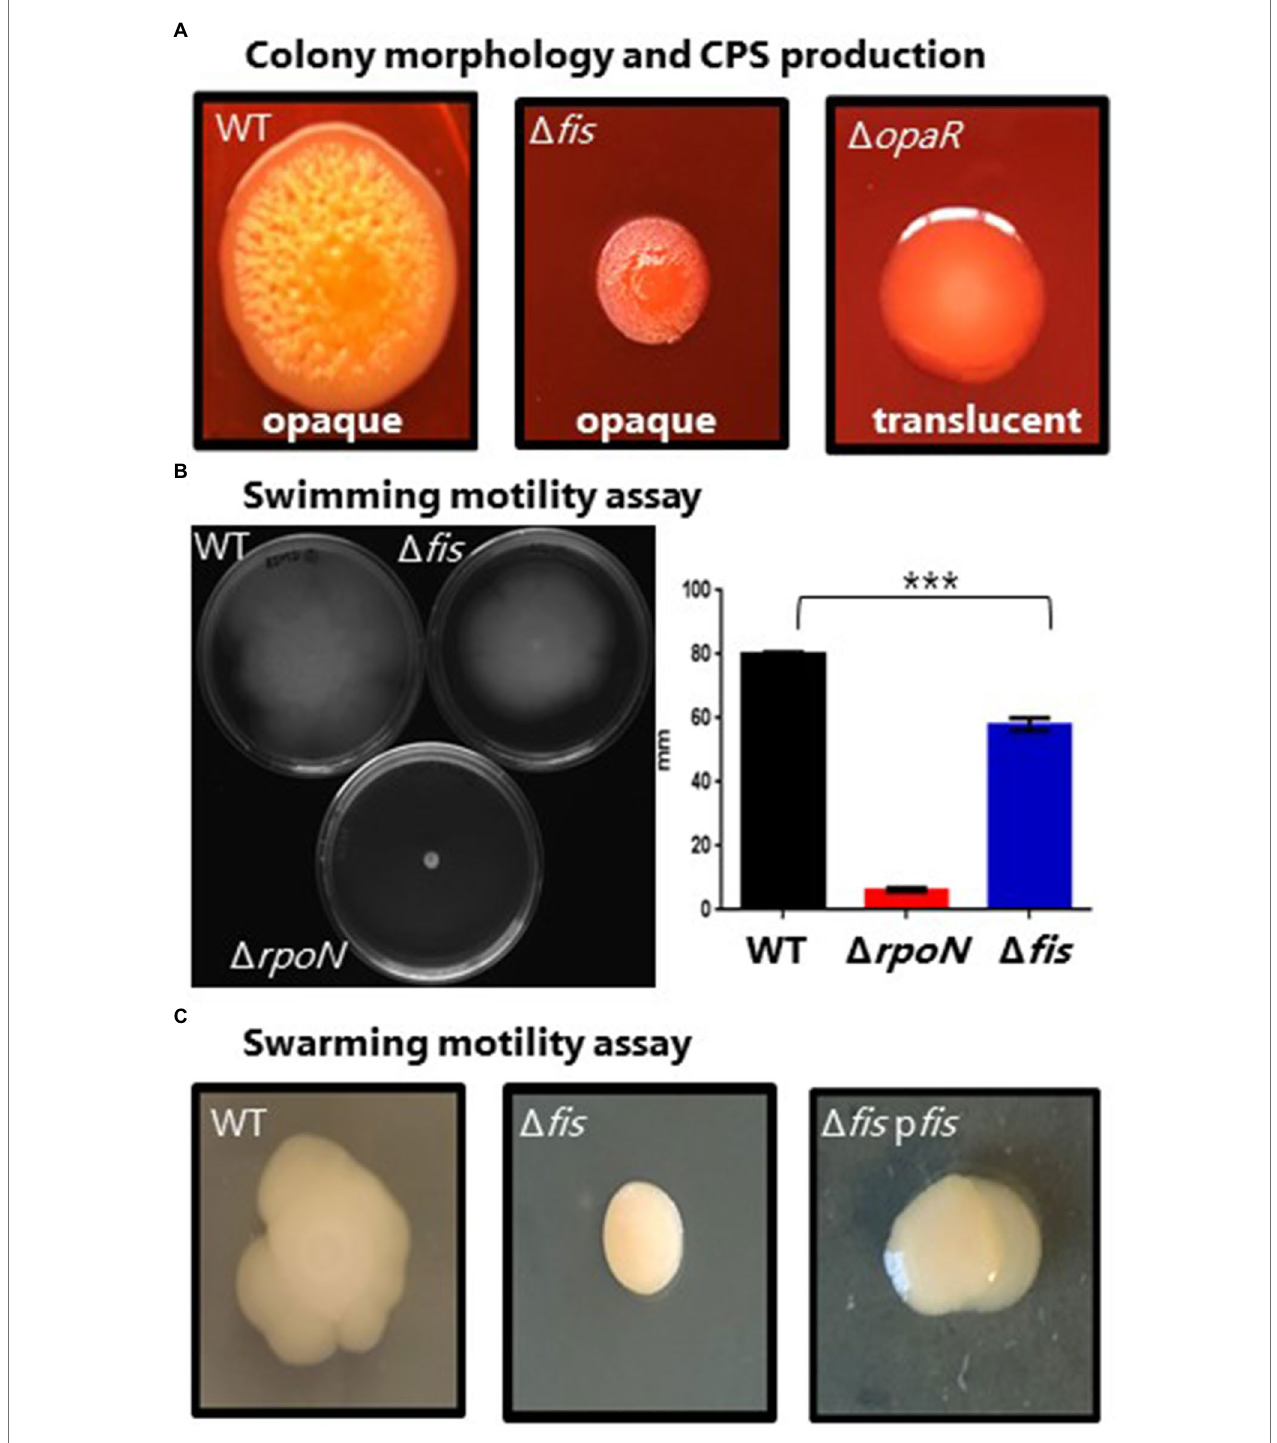
FIGURE 3 | Phenotypic analysis of the Δ fis mutant. (A) Capsule polysaccharide (CPS) production in wild type (WT), Δ fis and Δ opaR mutants was observed after incubation for 48 h at 30 ° C. Images are an example of three biological replicates performed in triplicate. (B) Swimming motility assays and quantification. Two biological replicates were measured, performed in triplicate. Statistics calculated using a Student’s t -test (*** p < 0.001). (C) Swarming motility assay of V. parahaemolyticus wild type and the Δ fis mutant and Δ fis complementation strain. Complementation assays were grown in the presence of Cm and IPTG. All images are examples from three biological